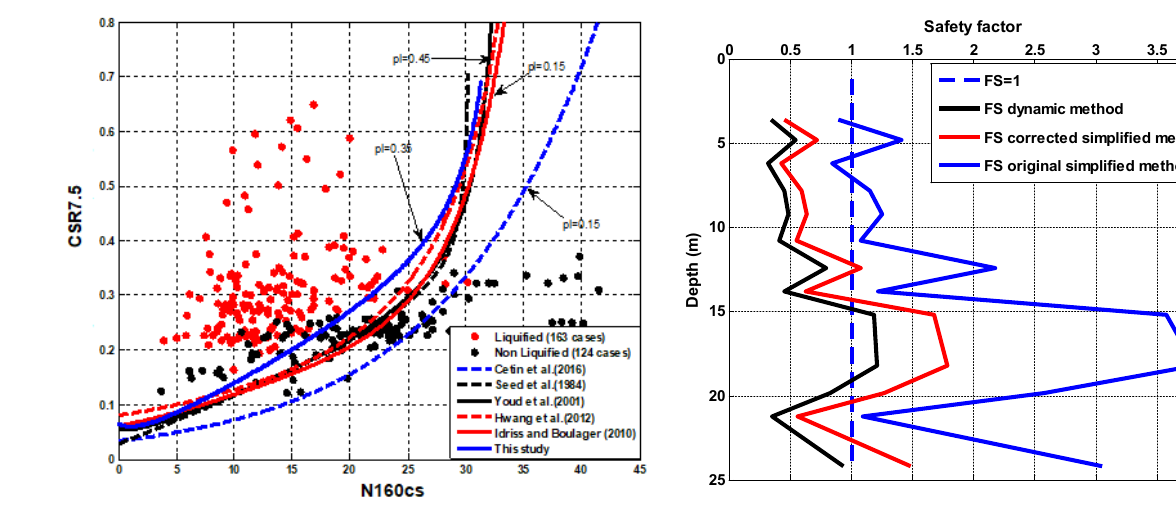
Figure7: Comparison of the original and the adjusted CRR- N curves. CRR = cyclic resistance ratio.